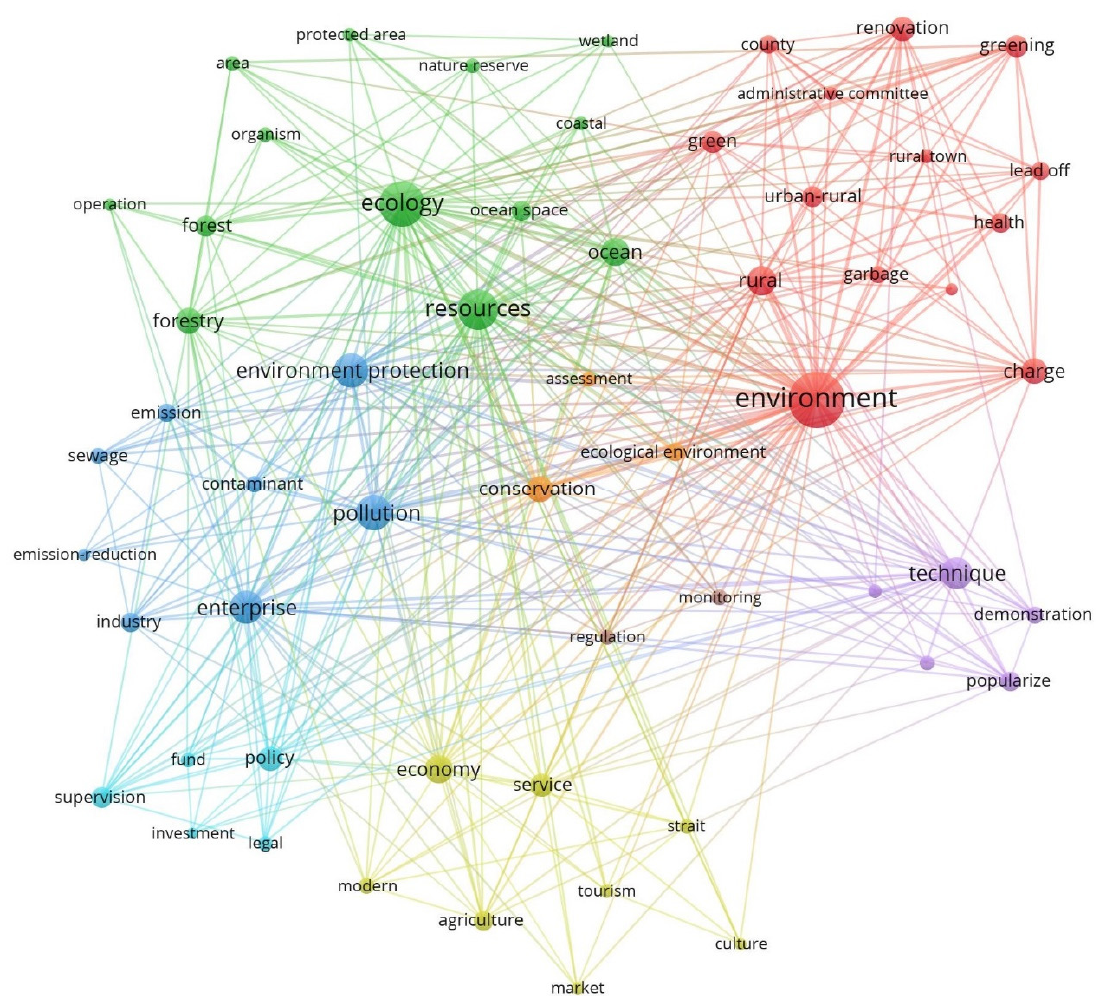
Figure 3. Co-word analysis and cluster analysis of keywords (2004–2012).